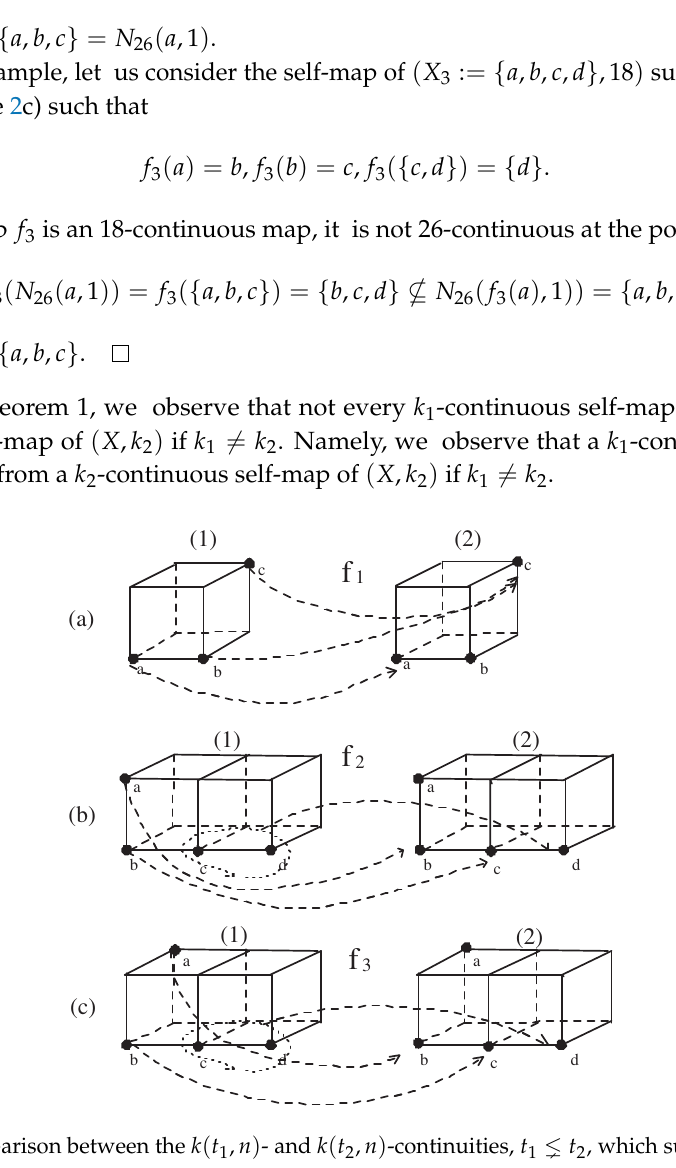
Figure 2. Comparison between the k ( t 1 , n ) - and k ( t 2 , n ) -continuities, t 1 (cid:12) t 2 , which supports the proof of Theorem 1. ( a ) 26-continuity of f 1 need not imply 18-continuity of it. ( b ) 6-continuity of f 2 need